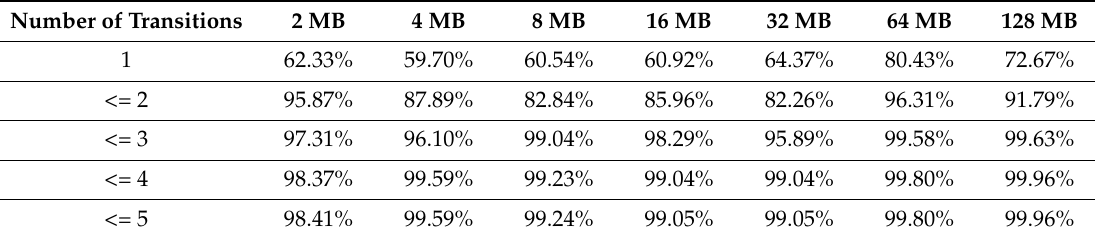
Table 1. Thread termination ratios with different input sizes.